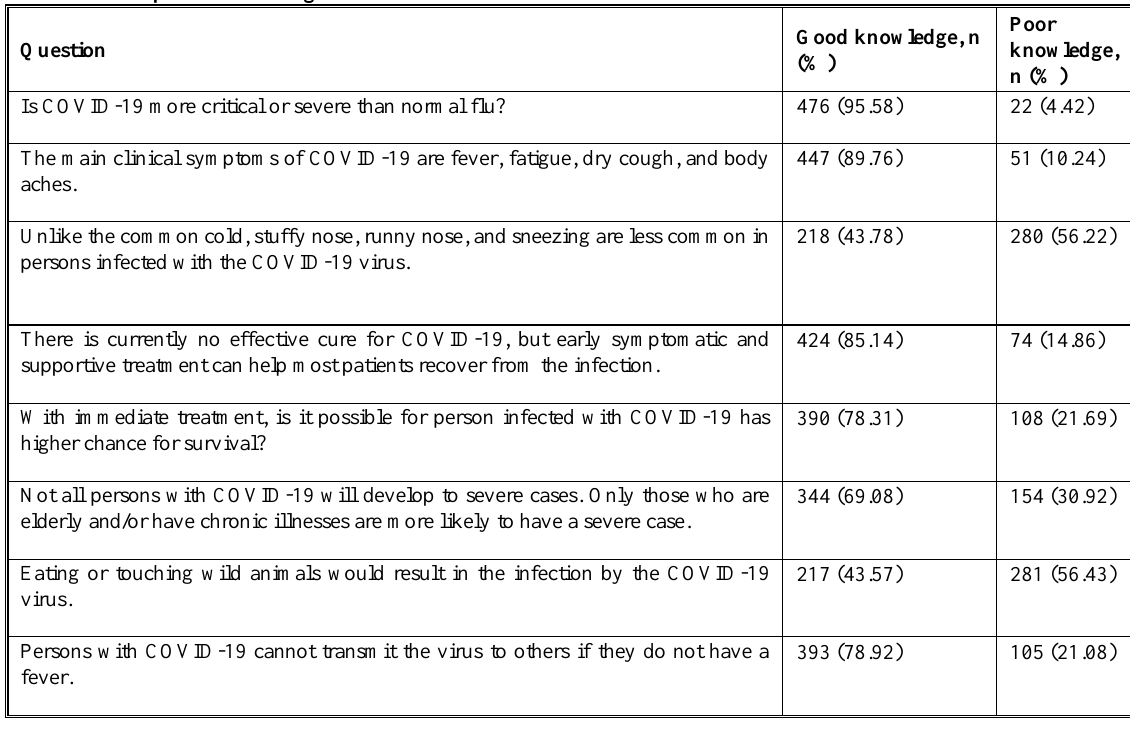
Table 2. Participants' Knowledge about